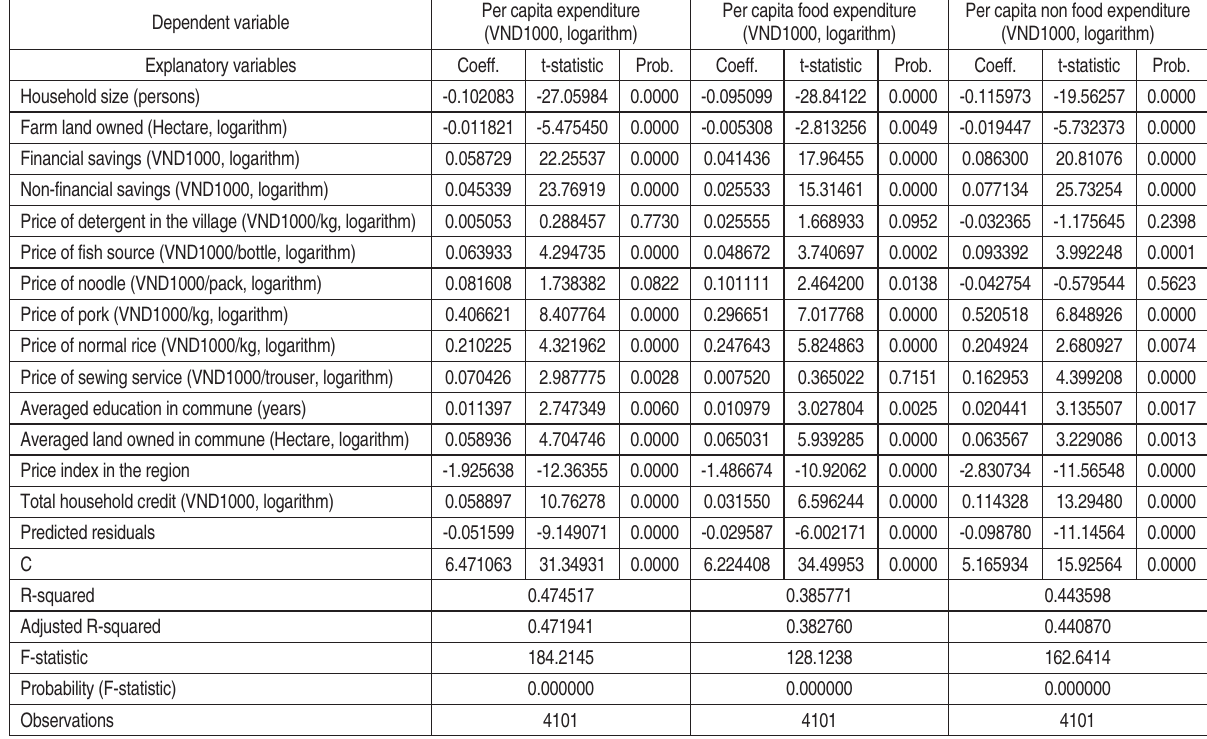
Table 4 (cont.). Second stage least squares regression: effect of credit on household welfares.